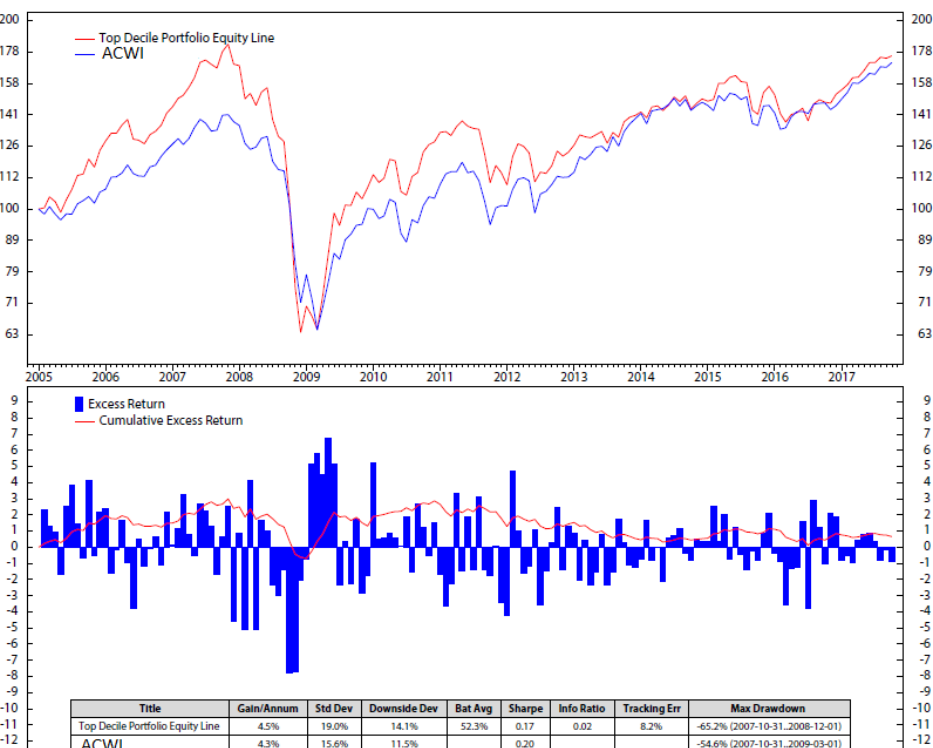
Figure 9. Top decile of valuation composite performance using the equally-weighted model from January 2005 to September 2017. The stock prices were scaled to $100.00 at the beginning of the stock selection process (January